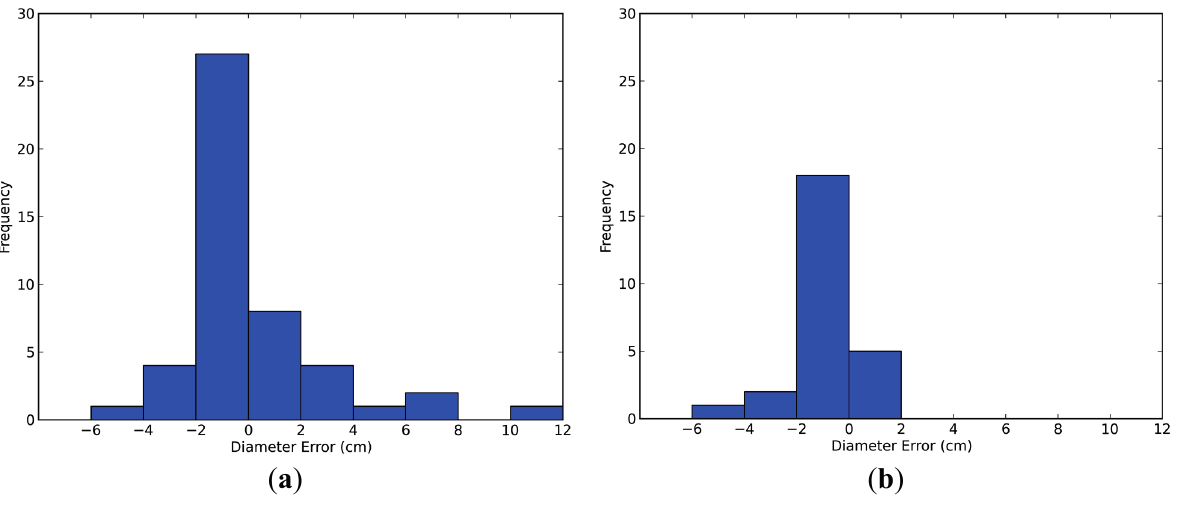
Figure 6. Distribution of DBH estimation differences between ZEB1 and FARO values with ( a ) no filter and ( b ) DBH > 10